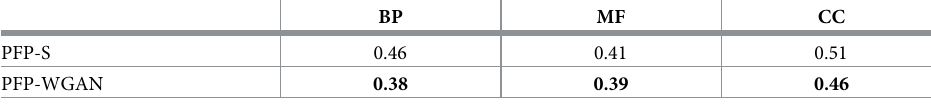
Table 3. MSE of PFP-WGAN and PFP-S against grandtruth.